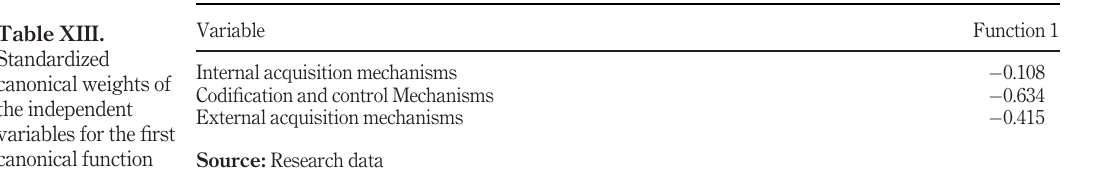
Table XIII. Standardized canonical weights of the independent variables for the fi rst canonical